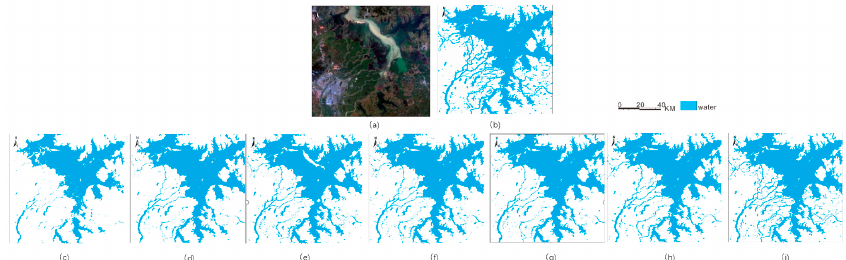
Figure 11. Remote sensing image and water extraction results of the different methods in research area 20160917: ( a ) FY-3/MERSI image; (b) Landsat data; ( c ) single-band threshold method; ( d ) water index method; ( e ) decision tree method; ( f ) supervised classification; ( g ) unsupervised classification;